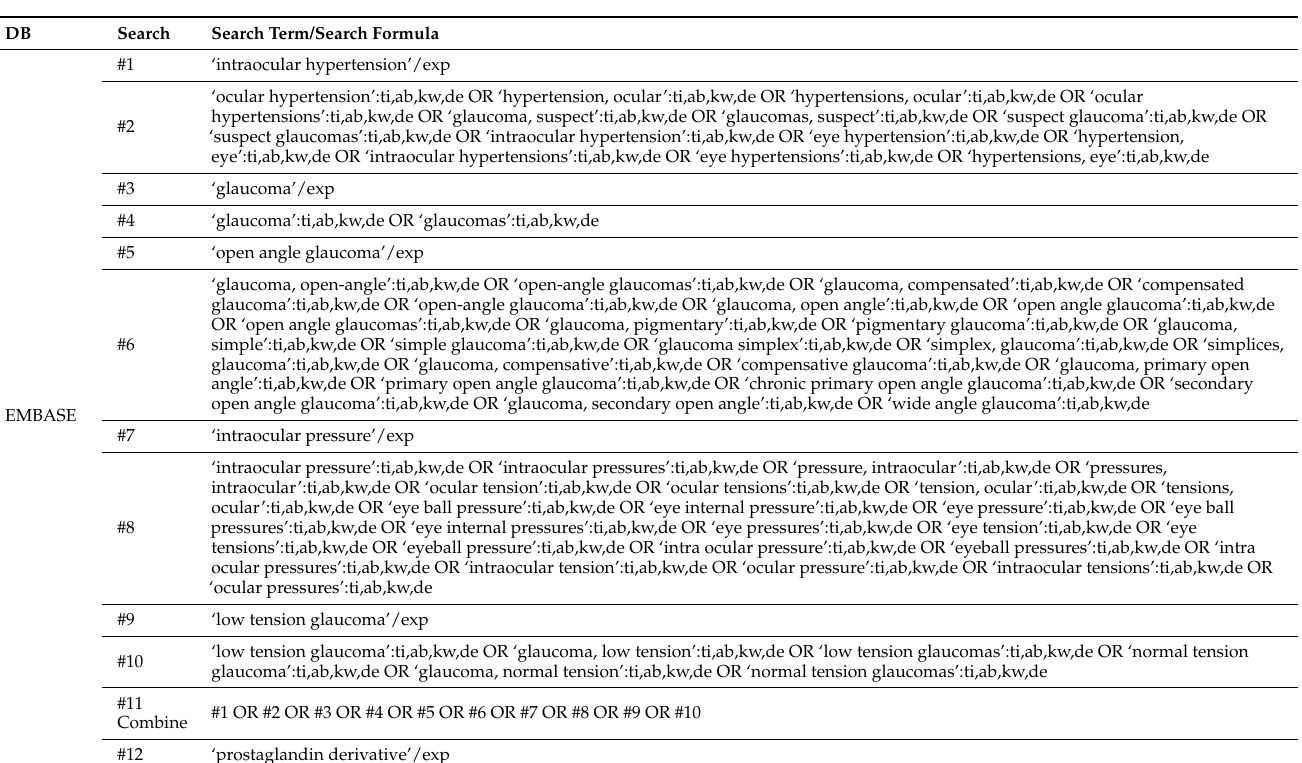
Table A2. Search terms and formula for EMBASE